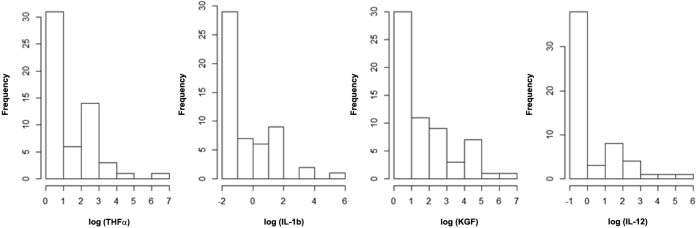
Histograms of the Log-Transformed Biomarker Values for (From Left to Right); Tumor Necrosis Factor (TNF)α, Interleukin (IL)-1b, Keratinocyte Growth Factor (KGF), and IL-12